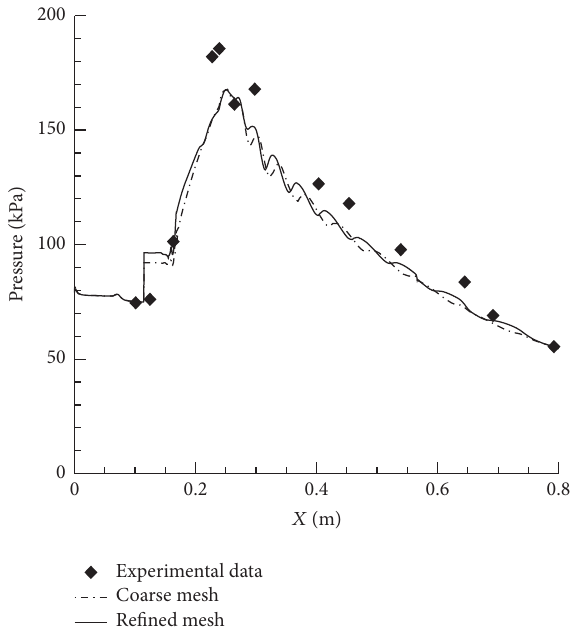
Figure3:Comparisonbetweenthepredicteddataandexperimental data (the data shown in this figure is the static pressure distribution along the top wall).